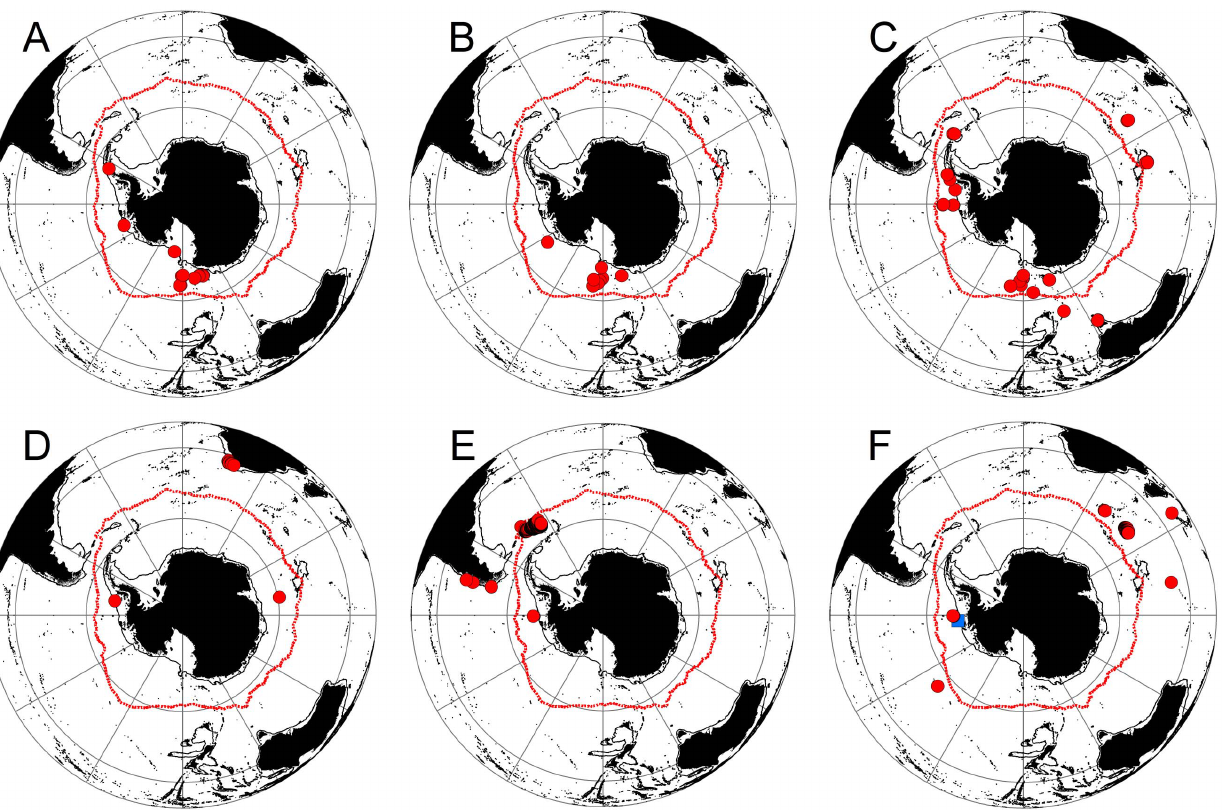
Figure 3. Distributions of anomuran crab species found south 60 u S. Neolithodes yaldwyni (A), Paralomis stevensi (B), Paralomis birsteini (C), Neolithodes capensis (D), Neolithodes diomedeae (E), Lithodes murrayi (F – red circle) and Munidopsis albatrossae (F – blue square). Red line=Mean position of Polar Front (Moore et al., 1999).